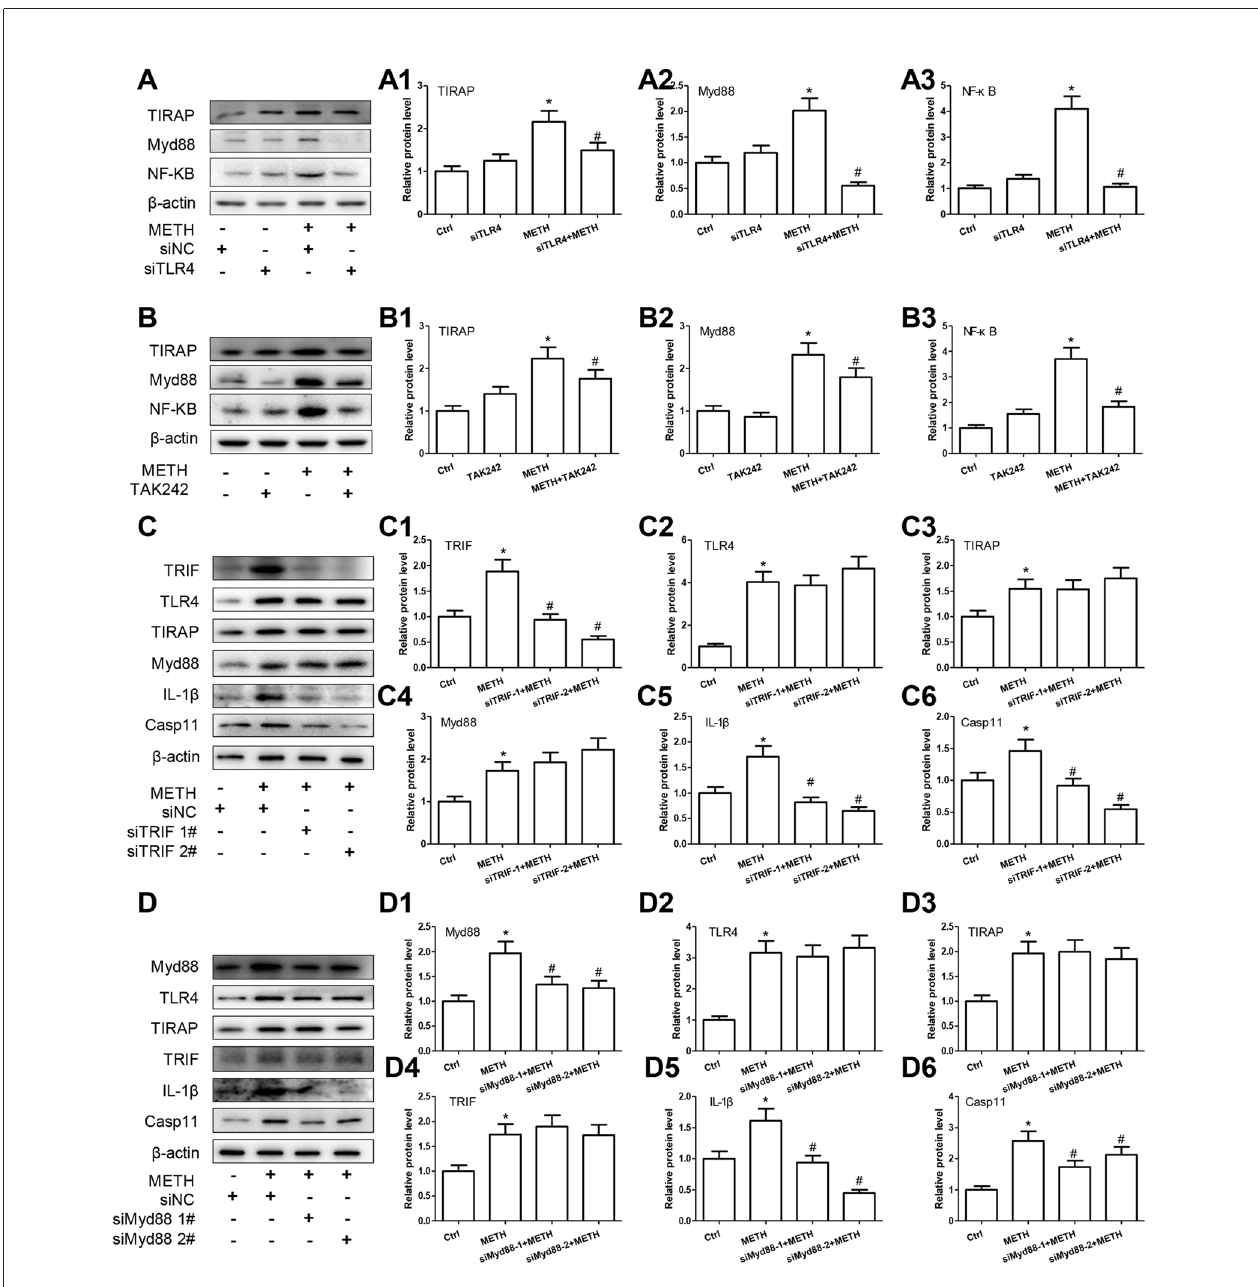
FIGURE 7 | TLR4 mediates METH-induced IL-1 β and IL-18 expression through both Myd88-dependent and Myd88-independent signaling pathways. Primary cultured astrocytes transfected with siRNAs targeting TLR4 (A–A3) , TRIF (C–C6) , Myd88 (D–D6) or control siRNA for 24 h followed by METH (2 mM) treatment for 24 h. Cells were exposed to TAK-242 (100 nM) (B–B3) for 2 h prior to METH (2 mM) treatment as indicated. Western blot (A–D) and quantitative analyses were performed to determine TLR4, TRIF, TIRAP, Myd88, NF- κ B, Caspase-11 and/or IL-1 β protein expression. All the experiments were repeated three times. Data are expressed as mean ± SD. ∗ p < 0.05 vs. non-METH-treated group. # p < 0.05 vs. the scrambled + METH treated group. Data in (A,B) were analyzed with 2 × 2 factorial ANOVA followed by LSD post hoc analyses; data in (C,D) were analyzed with two-way ANOVA followed by LSD post hoc analyses.